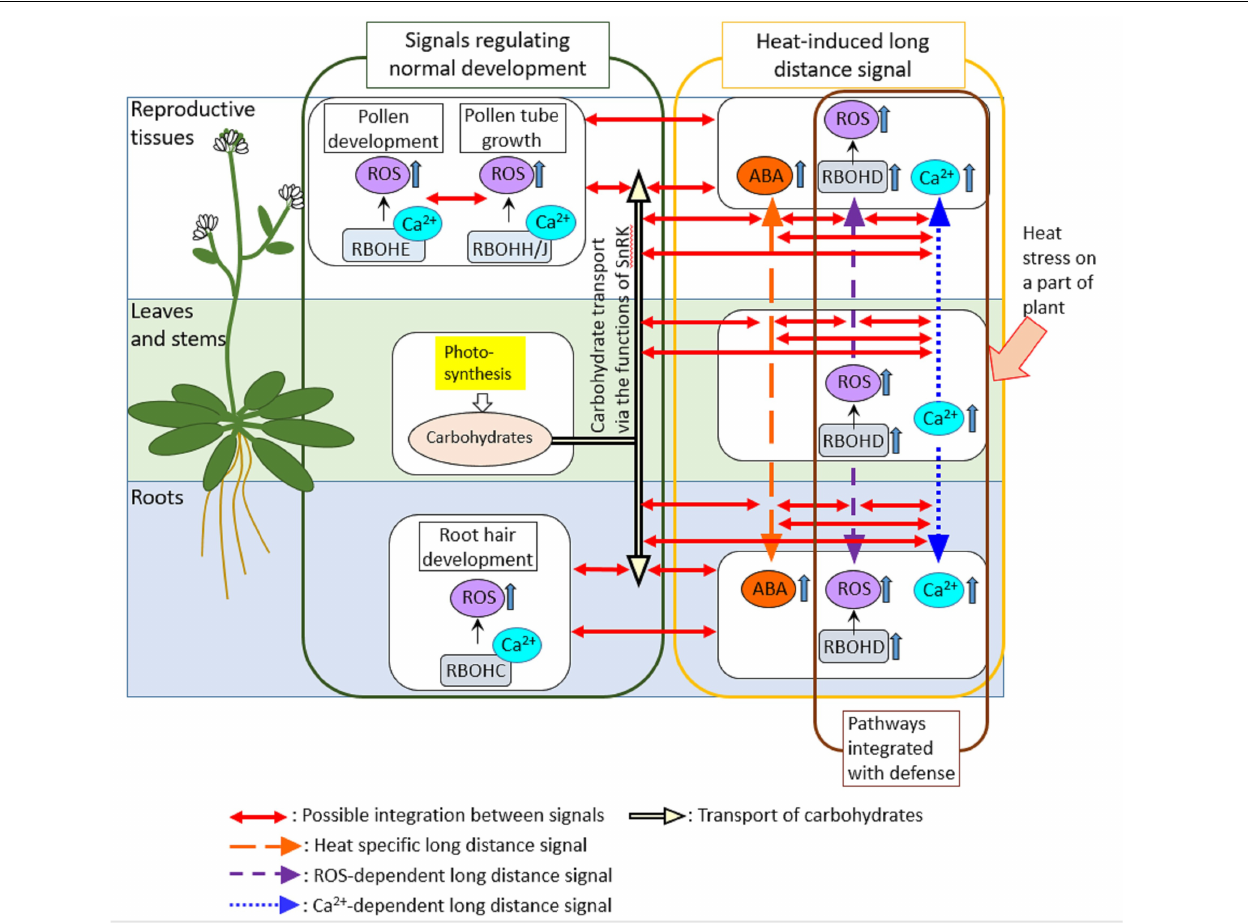
FIGURE 2 | Possible integrations of signals activated in different tissues. In this review, we suggest the possible integration between different signals that regulate development, heat response and pathogen defense in different tissues via ROS-dependent long-distance signaling. Long-distance signals that can be activated by heat stress and pathogens might involve Ca 2 + signals as well as RBOHD-dependent ROS signals. Therefore, other RBOH proteins that function in different tissues to regulate developmental processes could be activated by Ca 2 + signals propagated from the different part of the plant. In addition, carbohydrate transport that might be regulated by ABA signals could be also integrated with ROS- and Ca 2 + -dependent long-distance signals. Indeed, ABA was shown to function together with RBOHD-dependent ROS signals to activate heat-induced long-distance signaling (Suzuki et al., 2013a). Furthermore, tapetal PCD was also shown to be required for the delivery of carbohydrates necessary for pollen development, suggesting the integration between PCD pathways and mechanisms that regulate carbohydrate distributions in